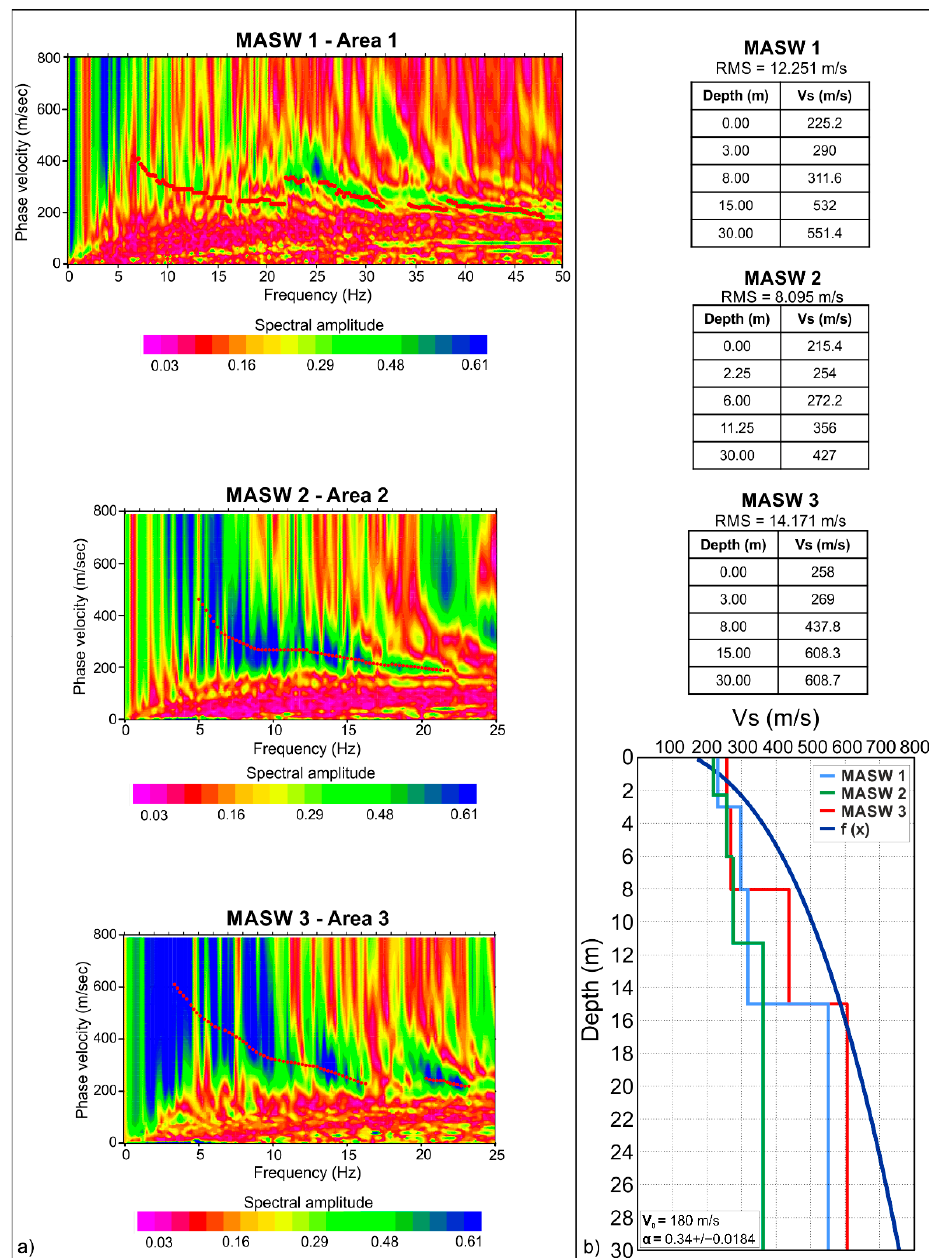
Figure 3. ( a ) Dispersion curves obtained from the three MASW surveys; ( b ) 1D velocity–depth profiles, where the blue curve represents the function (2) that has the minimum misfit with the data of the 1D velocity depth profiles obtained from the MASW surveys.